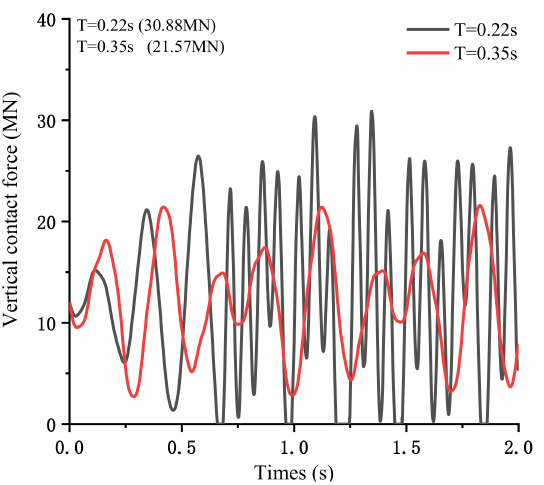
Figure 6. The vertical contact force of the bridge when T = 0.22 s and T = 0.5 s. When examining the effect of a longitudinal earthquake on the high-damping rubber bearing bridge, the damage appeared at the bottom of the